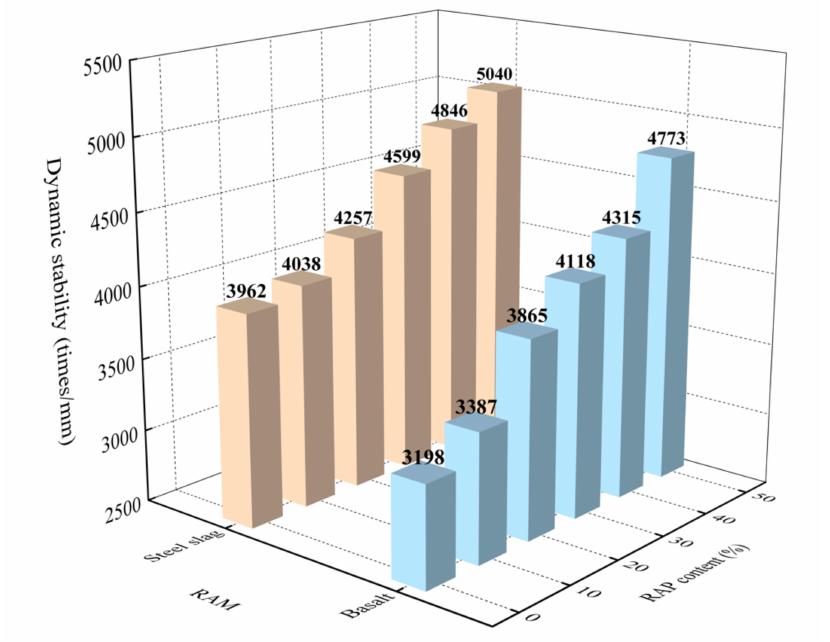
Figure 7. Dynamic stability results of RAM.